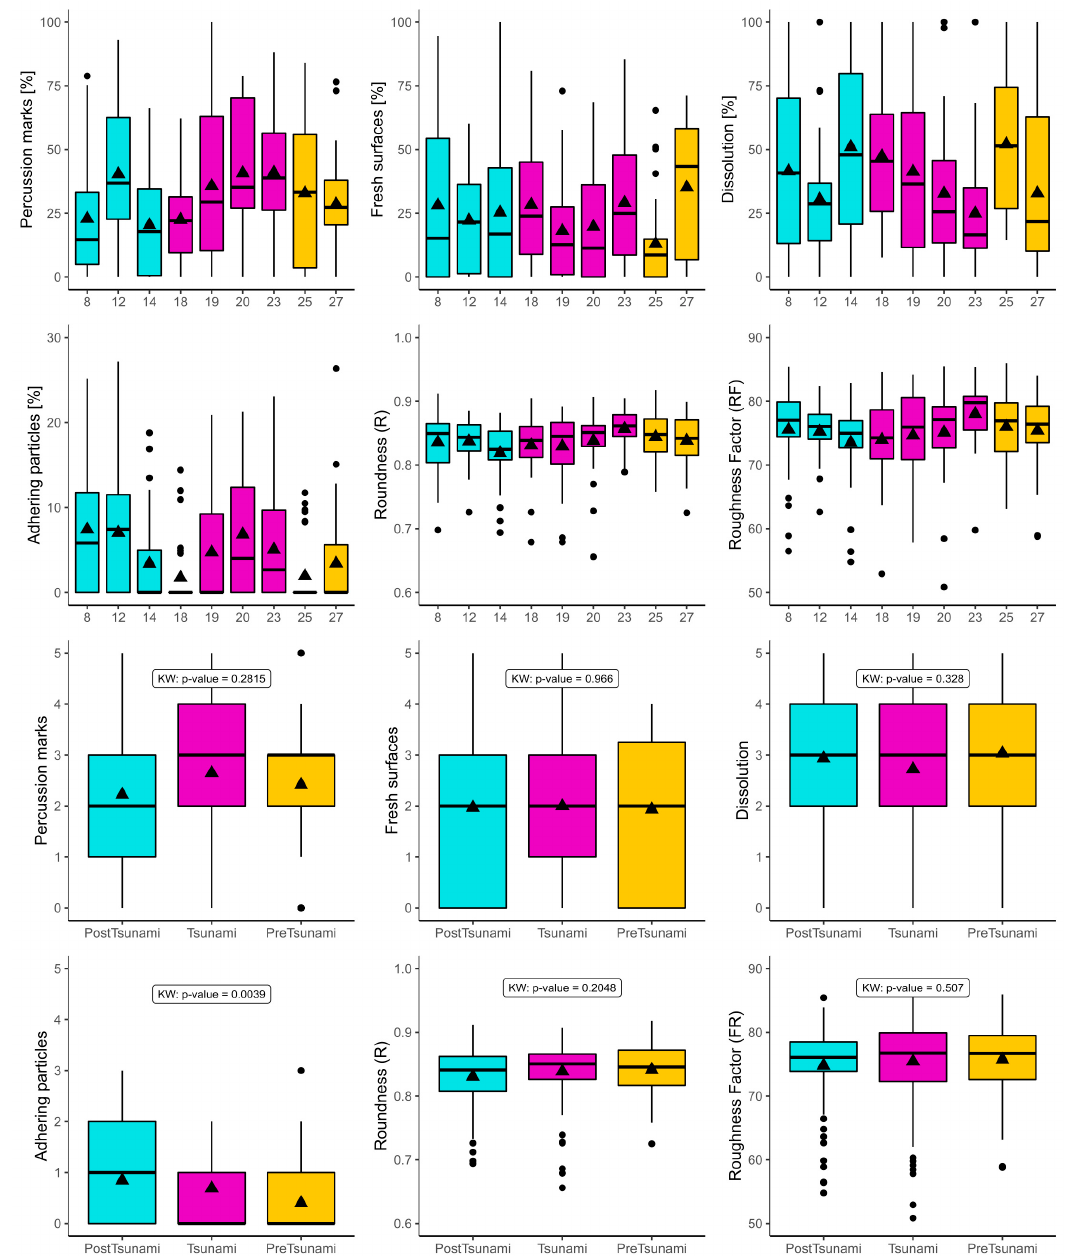
Figure 11. Boxplots of each microtextural family, roundness parameter (R), and roughness factor (FR). Distributions of each sample are depicted and after the grouping of samples in their respective chronological group with calculated p-values using Kruskal-Wallis test. Black points indicate outliers, black triangles indicate mean values while black lines indicate the median.